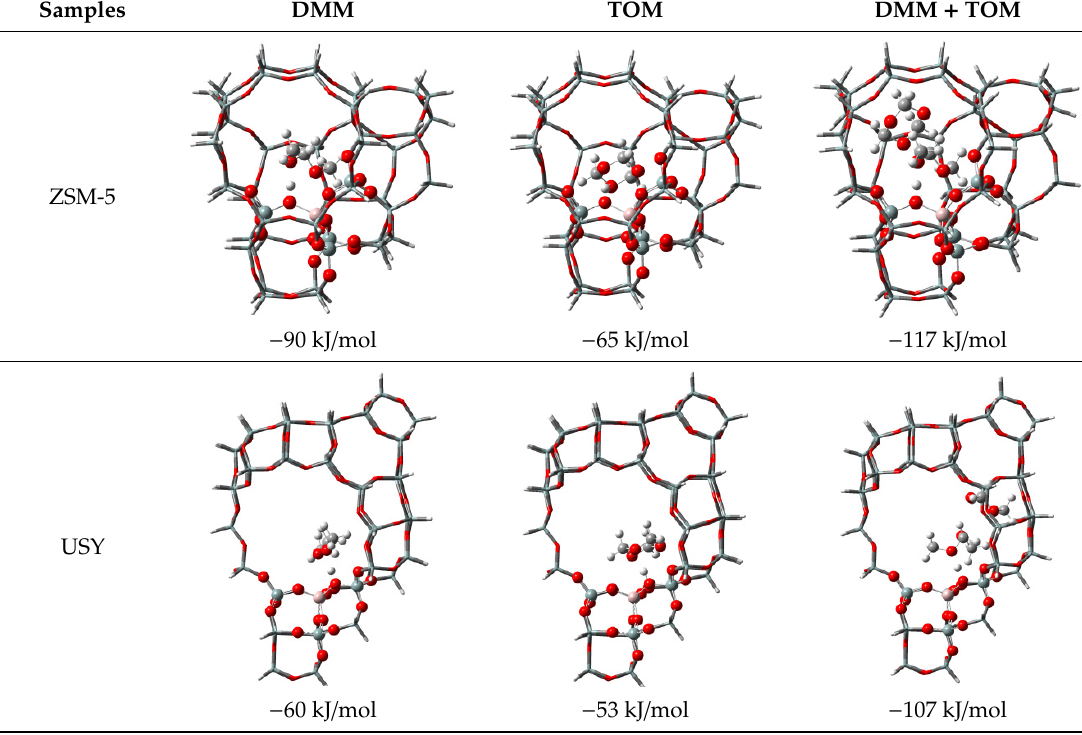
Table 4. Adsorption energy of DMM, TOM, and their combination in ZSM-5 and USY.